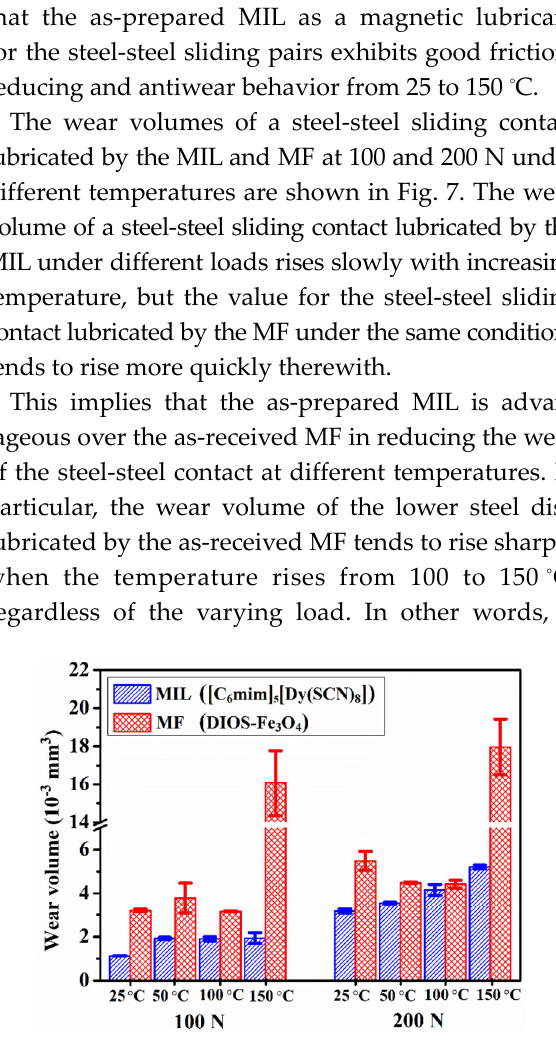
Fig. 7 Wear volumes of a steel-steel sliding contact lubricated by the MIL and MF at different temperatures (25, 50, 100, 150 ° C) and loads (100 and 200